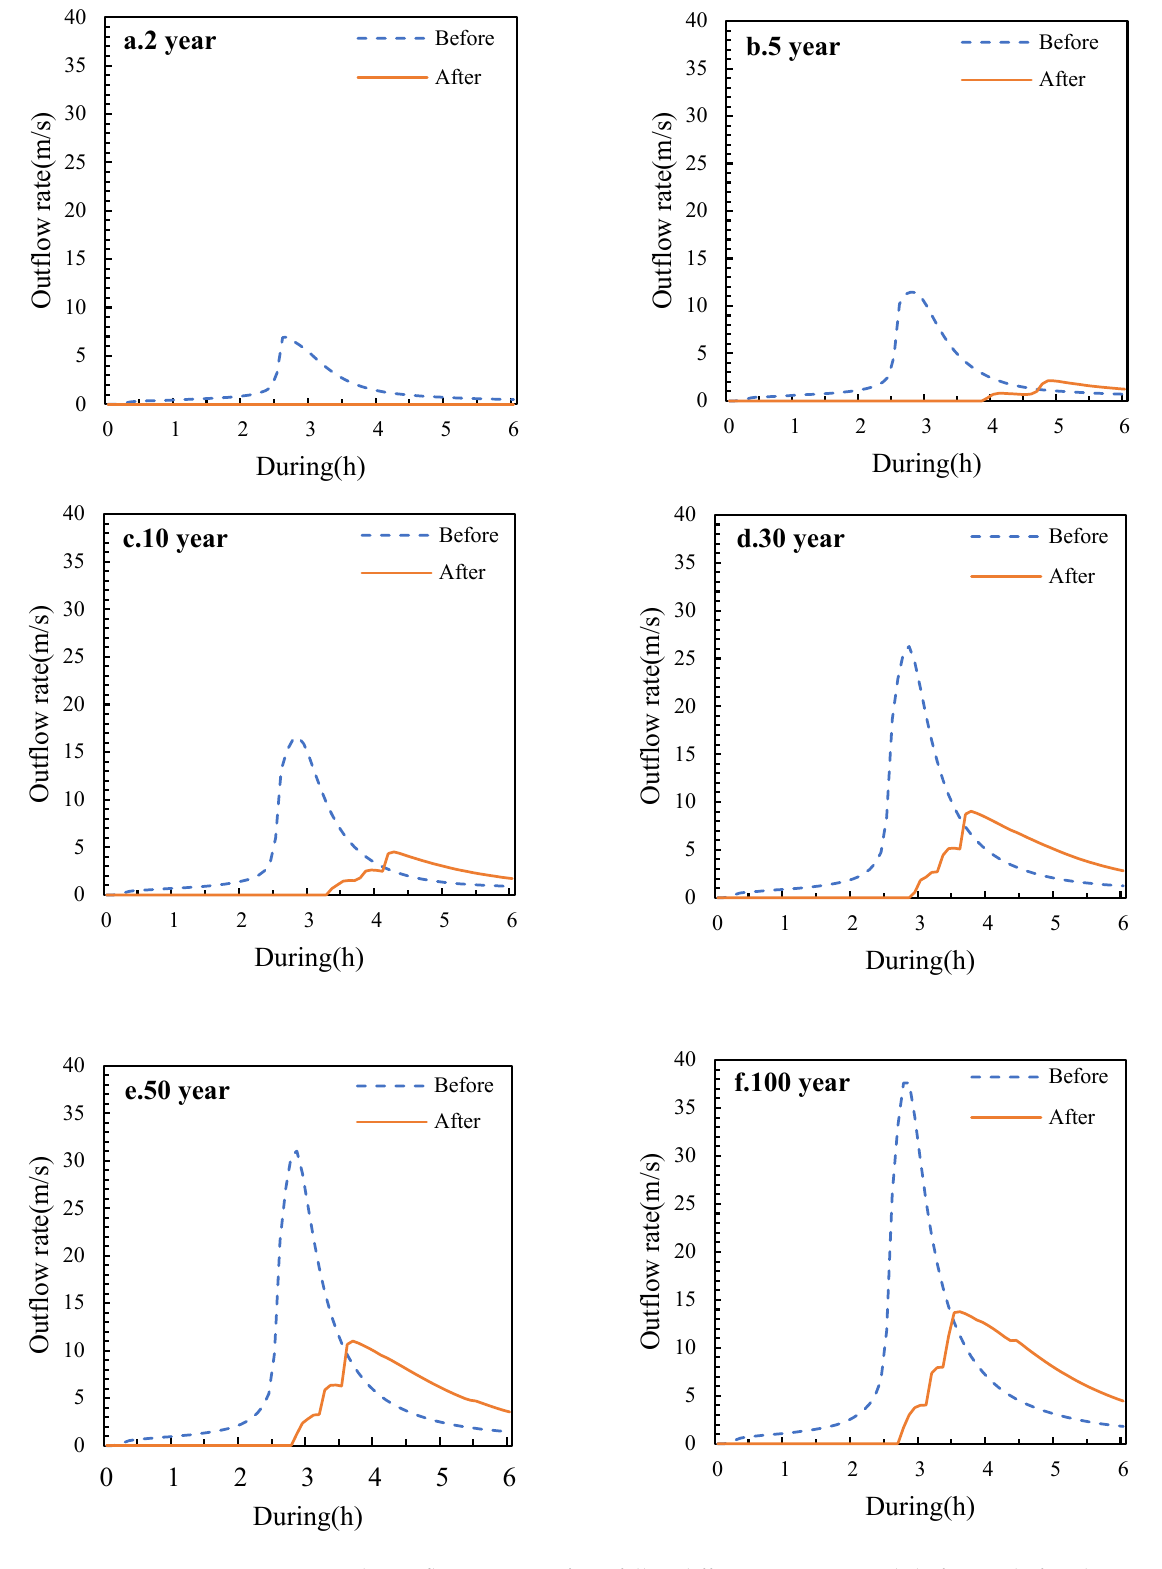
Figure 9. The outflow process of rainfall in different return periods before and after the construction of the research area.